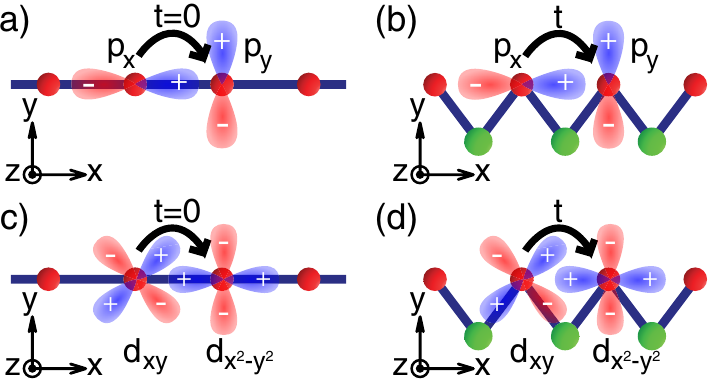
Figure 1. Interorbital-hopping mechanism for orbital angular momentum. ( a , b ) Atomic chains with two p orbitals at each red atom. ( c , d ) Atomic chains with two d orbitals at each red atom. In ( a , c ), the interatomic hopping between different-parity orbitals is zero due to a mirror plane parallel to the xz plane. In ( b , d ), the presence of green atoms does not remain any mirror plane parallel to the xz plane, producing nonzero interatomic hopping between different-parity